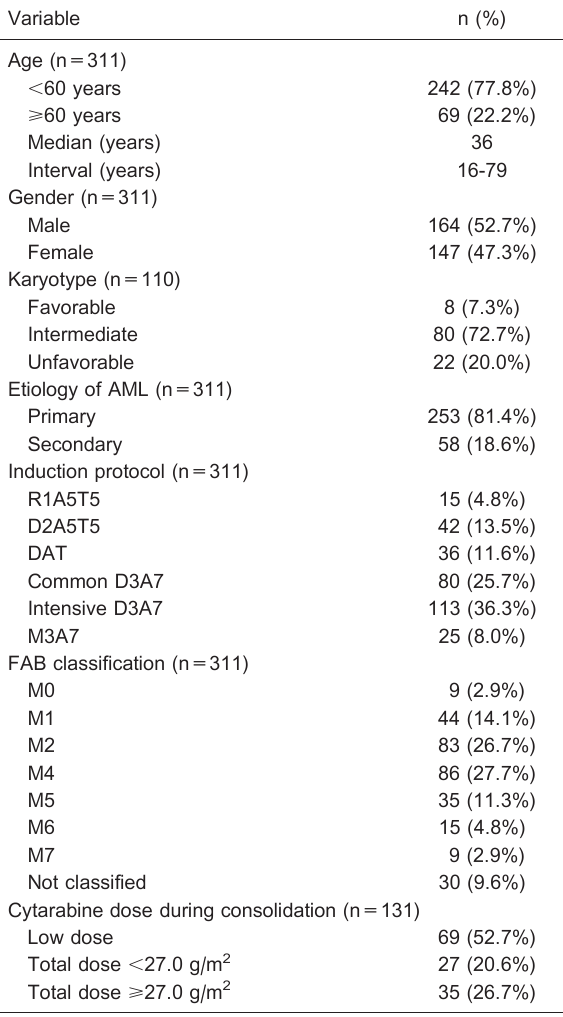
clinical characteristics of the patients are shown in Table 1. Table 1. Clinical and demographic characteristics of the